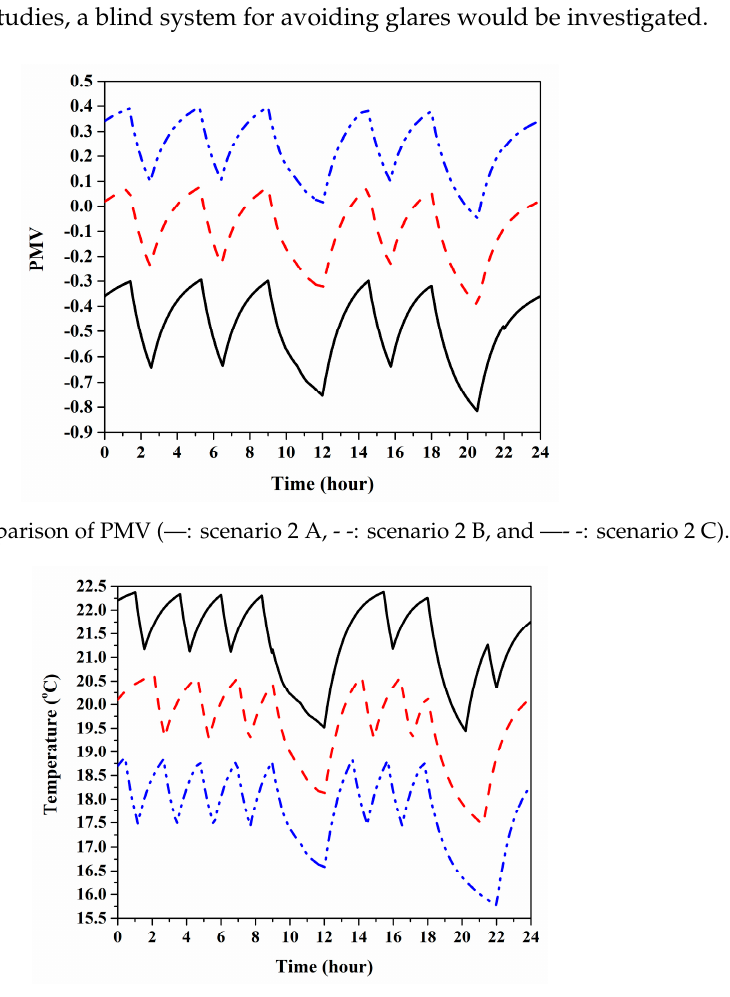
Figure 9. Comparison of indoor temperature (—: scenario 2 A, - -: scenario 2 B, and —- -: scenario 2 C).